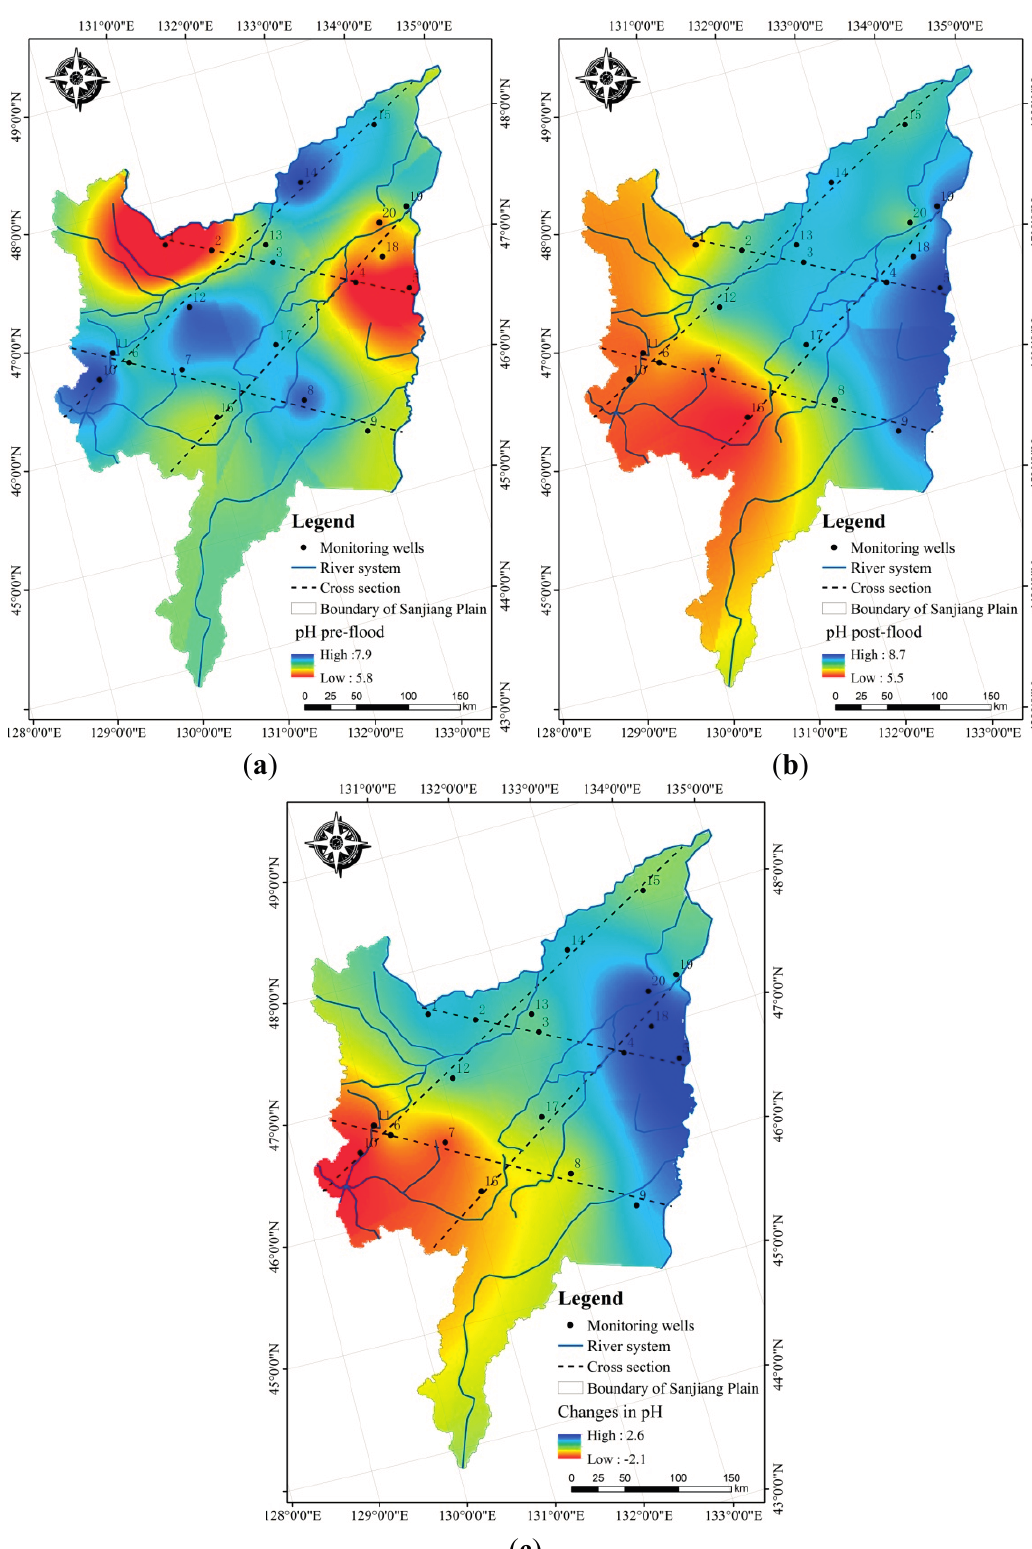
Figure 5. Changes in shallow groundwater pH following the 2013 summer flood in the Sanjiang Plain, Northeast China: ( a ) pre-flood; ( b ) post-flood; and ( c ) changes between pre- and